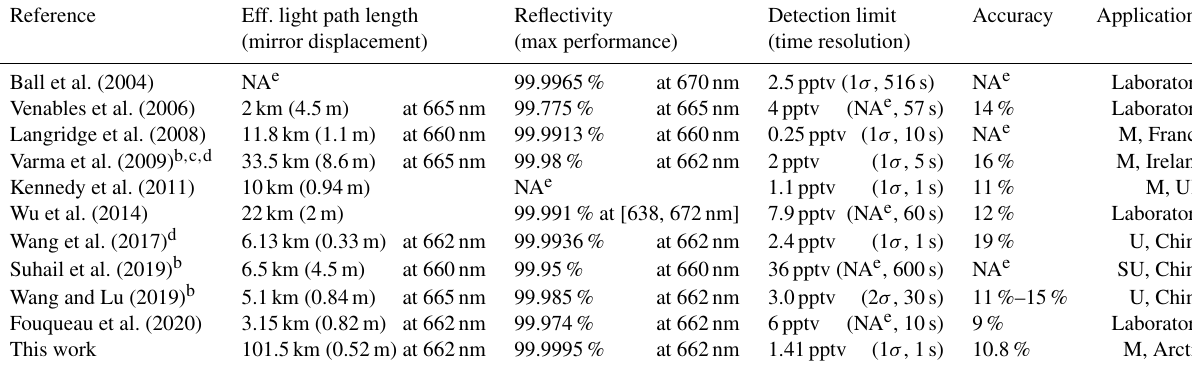
Table 1. Comparison of BBCEAS performances for NO 3 measurement. Reference